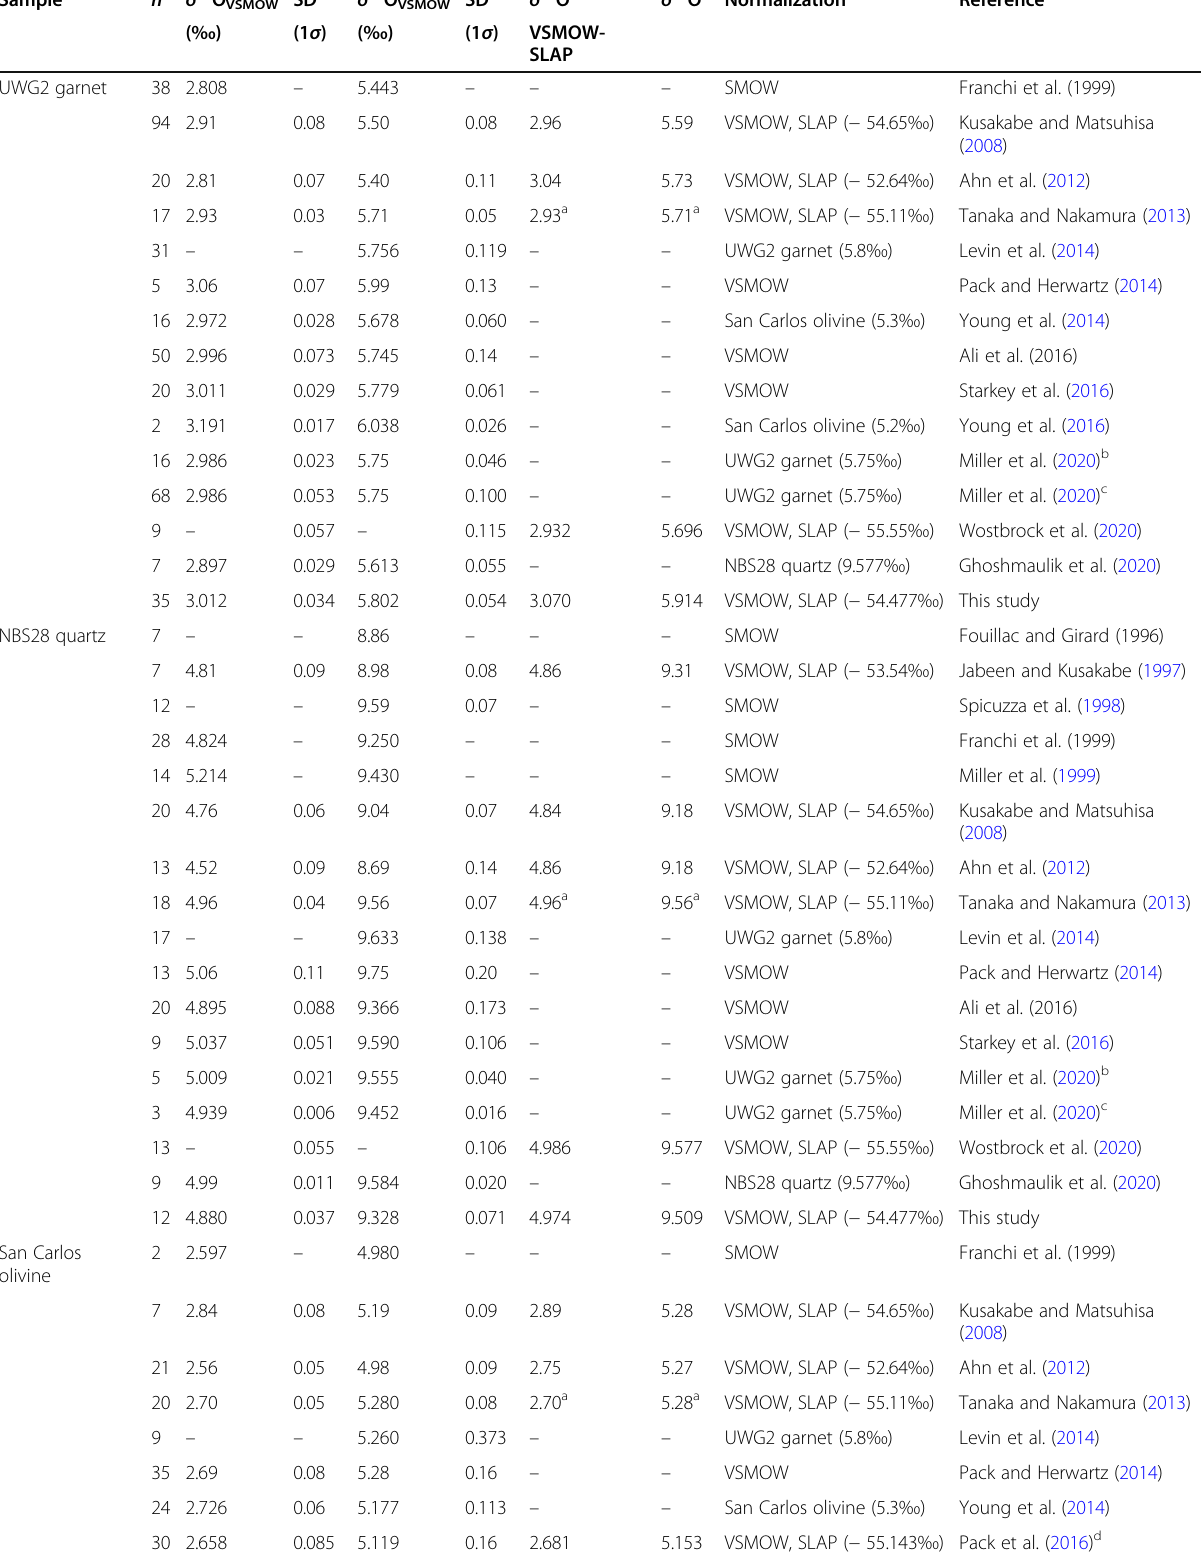
Table 3 Literature data of δ 17 O and δ 18 O for the international silicate standards and normalization methods